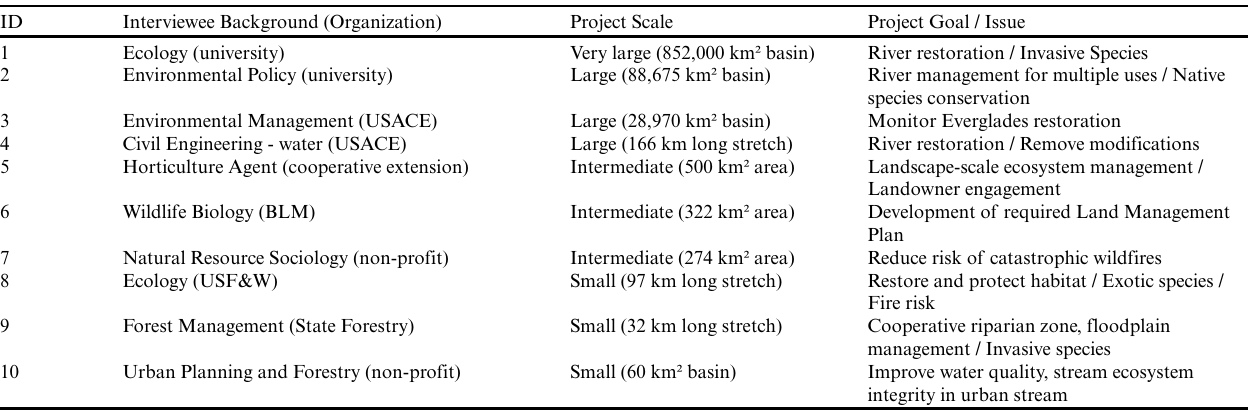
Table 2 . Characteristics of the interviewees and the projects they described. The ID numbers are used in Appendix 2 to identify recommendations from each interviewee.